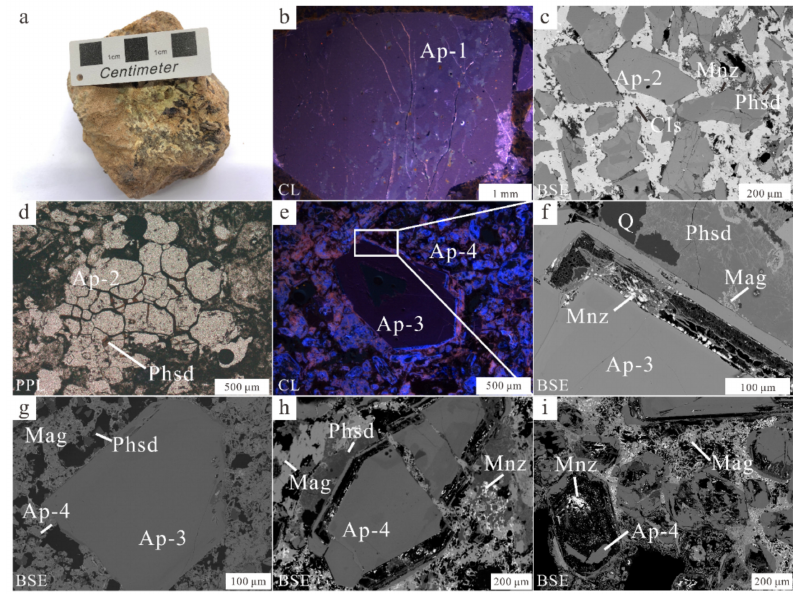
Figure 3. Transmitted plane-polarized light, cathodoluminescence, and back-scattered electron pho- tomicrographs illustrating the key petrographic features of magnetite-apatite-enriched rocks and the dominant apatite. ( a ) Hand specimen of the yellowish magnetite-apatite-enriched rocks; ( b ) coarse- grained magmatic apatite (Ap-1) displaying heterogeneous purple luminescence with dispersed yellow luminescent zones; ( c ) fine-grained magmatic apatite (Ap-2) associated with anhedral fine- grained celestine (Cls), phosphosiderite (Phsd), and minor monazite (Mnz); ( d ) fine-grained magmatic apatite aggregates with phosphosiderite occurring along the grain boundaries; ( e ) coarse-grained slightly altered apatite (Ap-3) showing dark purple luminescence associated with fine-grained al- tered apatite (Ap-4) illustrating various levels of blue-purple luminescence; ( f ) fine-grained monazite crystals deposited in the fissures along a slightly altered apatite (Ap-3) rim associated with phospho- siderite, magnetite (Mag), and a minor concentration of quartz (Q); ( g ) Ap-3 showing a thin darker rim on the BSE images; ( h ) fractured Ap-4 with magnetite, phosphosiderite, and secondary monazite precipitated in the fissures or along the boundaries; ( i ) fine-grained monazite aggregates crystallized in the Ap-4 hollows and along the boundaries associated with hydrothermal